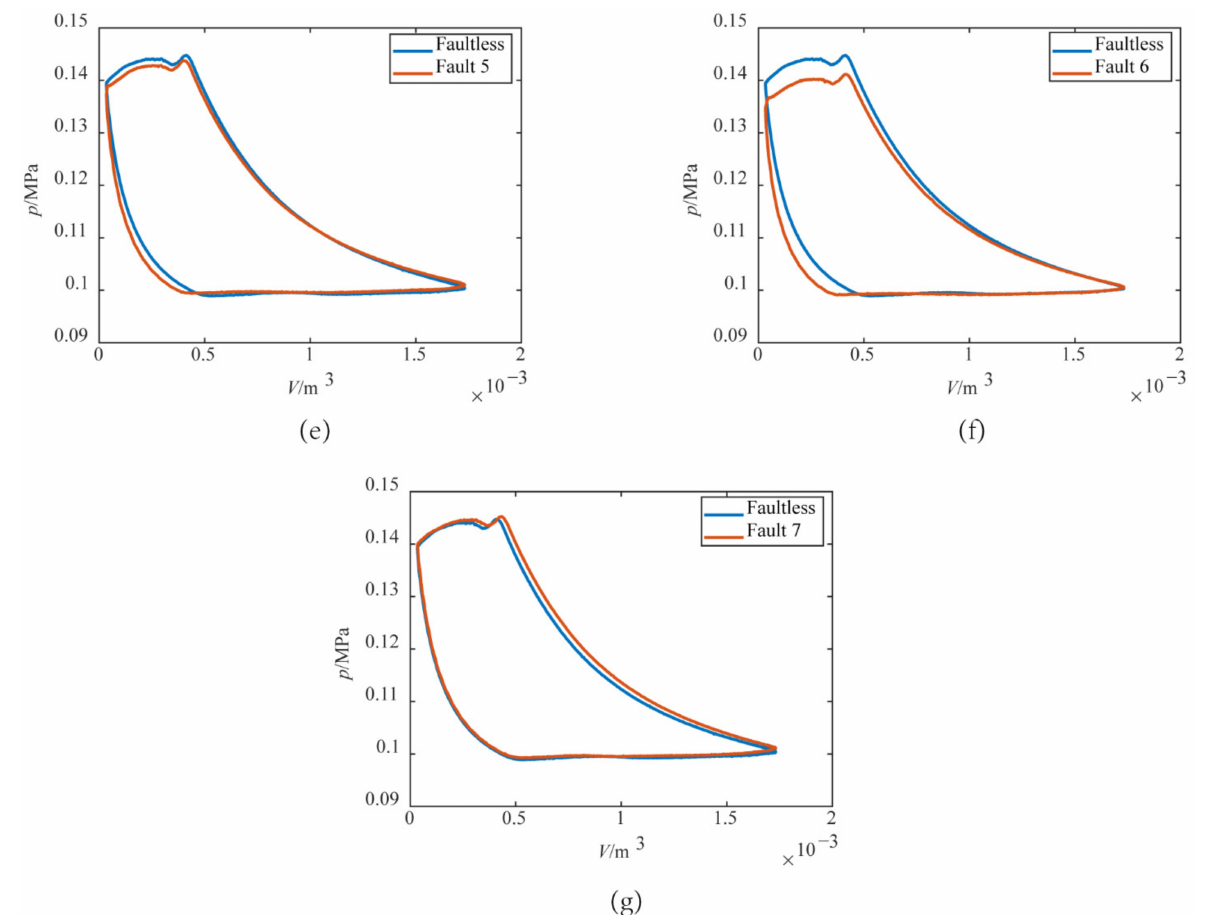
Figure 7. Comparison of faulted and faultless diagrams: ( a ) Fault 1 and Faultless; ( b ) Fault 2 and Faultless; ( c ) Fault 3 and Faultless; ( d ) Fault 4 and Faultless; ( e ) Fault 5 and Faultless; ( f ) Fault 6 and Faultless; ( g ) Fault 7 and